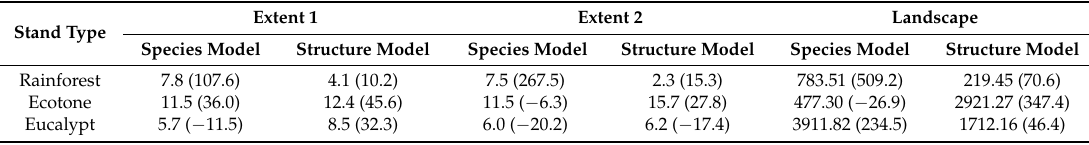
Figure 6. Stand type classifications from landscape species model, landscape structure model, predictive ecosystem mapping (PEM) model, and ecological vegetation classes (EVCs) across a subset of the study region encompassing extent 1 (see Figure 1). Other forest and non-forest regions predicted by the PEM model indicate the absence of Eucalyptus delegatensis and Eucalyptus regnans , or a canopy height less than 6 m, respectively. EVCs are listed in parenthesis where they differ from PEM classes. Table 4. Area of each stand type (km 2 ) as predicted by the landscape species model and the landscape structure model across the landscape and for two 5 km × 5 km subset extents (see Figure 1 for extents). Values in parenthesis are the percentage difference in area compared to the final predictive ecosystem mapping